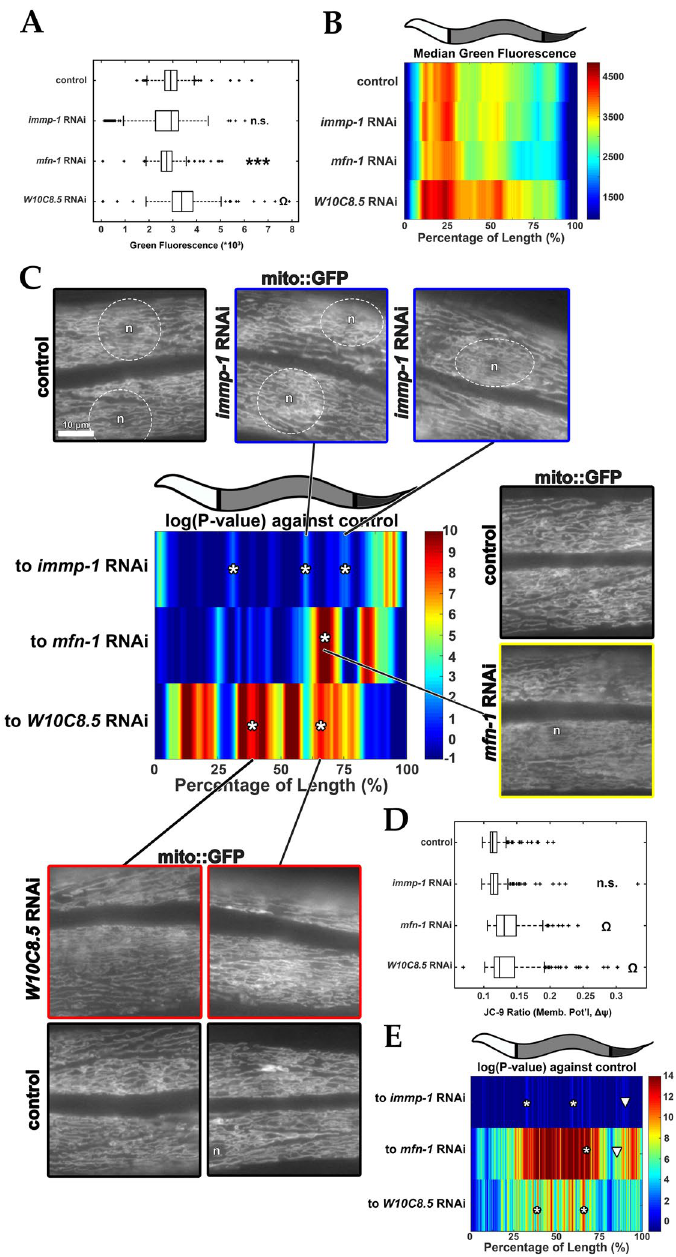
Figure 7. Mitochondrial morphology screening after treating C . elegans with selected RNAi’s. ( A ) Mitochondrial mass after selected RNAi knockdown of mitochondrial morphology genes. Muscle-specific, mitochondria-localized MLS2::GFP = “mito::GFP”. “n.s.” = not significant, *** P < 0.001, and “Ω” = P < 0.00001. ( B ) Median profiles of mitochondrial MLS2::GFP after RNAi treatments. ( C ) Significance (log 10 ( P-value )) plots derived from median profiles in ( B ) compared to “empty vector” (control). Asterisks ( * ) = regions that deviate significantly from controls. For significance plots, a value ≥ 0 is equivalent to P ≤ 0.05 by Wilcoxon Rank Sum Test. Plots are representative of two biological replicates of n ≥ 100 organisms. High magnification micrographs of muscle-specific, matrix-localized MLS2::GFP signal, across a representative animal for control (empty vector, black boxes), immp-1 RNAi (blue boxes), mfn-1 RNAi (yellow box), and W108 . 5 RNAi (red boxes). Scale bar is 10 µ m. Muscle cell nuclei = “n”. ( D ) Mitochondrial membrane potential, Δψ (by JC-9 ratio) after RNAi treatments in ( A–C ). *** P < 0.001, and “Ω” = P ≤ 0.00001. ( E ) Significance (log 10 ( P-value )) plots derived from median Δψ comparing each profile to “empty vector” treated “controls. Asterisks ( * ) = identified sites in ( C ) where Δψ is also affected. White arrowheads = positions where both mitochondrial morphology (in C ) and Δψ are affected. Plots in ( D , E ) are representative of four biological replicates of n ≥ 100 organisms. Sample size ( n ) for all experiments and exact P-values for Wilcoxon Rank Sum tests against empty vector “control” can be found in the Supplementary Table. L.A. Daniele provided the